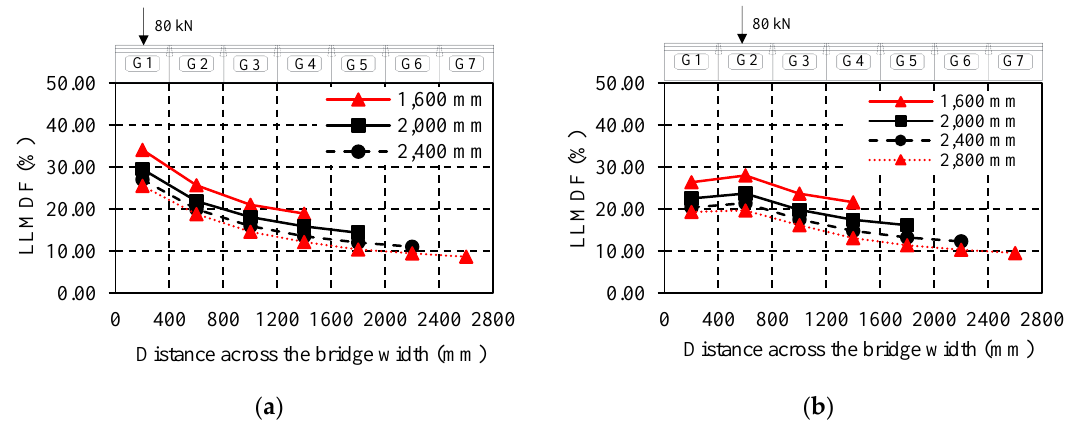
Figure 17. Mid-span LLMDFs for different bridge widths: ( a ) exterior girder G1 loaded and ( b ) interior girder G2 loaded.